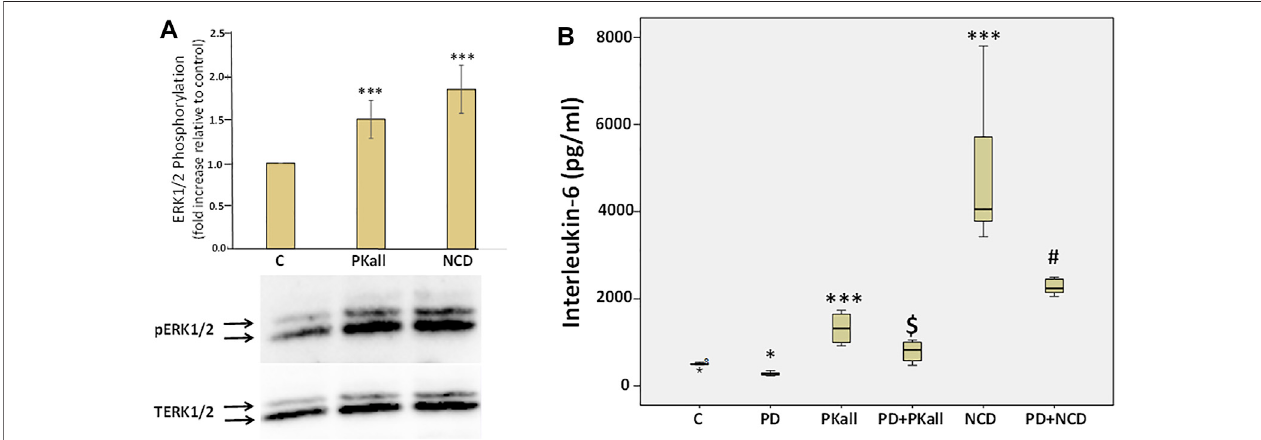
FIGURE 6 | Role of extra cellular regulated kinase1/2 (ERK1/2) in PKall and neuronal cell debris induced IL-6 production in microglial cells. (A) PKall and NCD stimulatedERK1/2phosphorylation(pERK1/2)inmicroglialcells.N9microglialcellswereexposedtoPKall(2.5 ng/ml)and/orNCD(16.5 μ gprotein/ml)for10 minpERK and total ERK (TERK) levels were assessed by western blot. Bar graph represents the fold change in pERK relative to TERK protein levels (* p < 0.001 n (cid:1) 6). (B) N9 microglial cells were stimulated with PKall (2.5 ng/ml) and/or NCD 16.5 μ g protein/ml) for 24 h in the presence and absence of the MEK 1 inhibitor PD98059 (25 μ M). Box plot represents the production and release of IL-6 levels into the media measured by ELISA in the different treatment groups. (* p ≤ 0.05, control vs. PD; *** p -value ≤ 0.001, PKall or NCD vs. Control; $ p ≤ 0.004, PKall vs. PD + PKall; # p ≤ 0.002 NCD vs. PD + NCD, n (cid:1) 6).